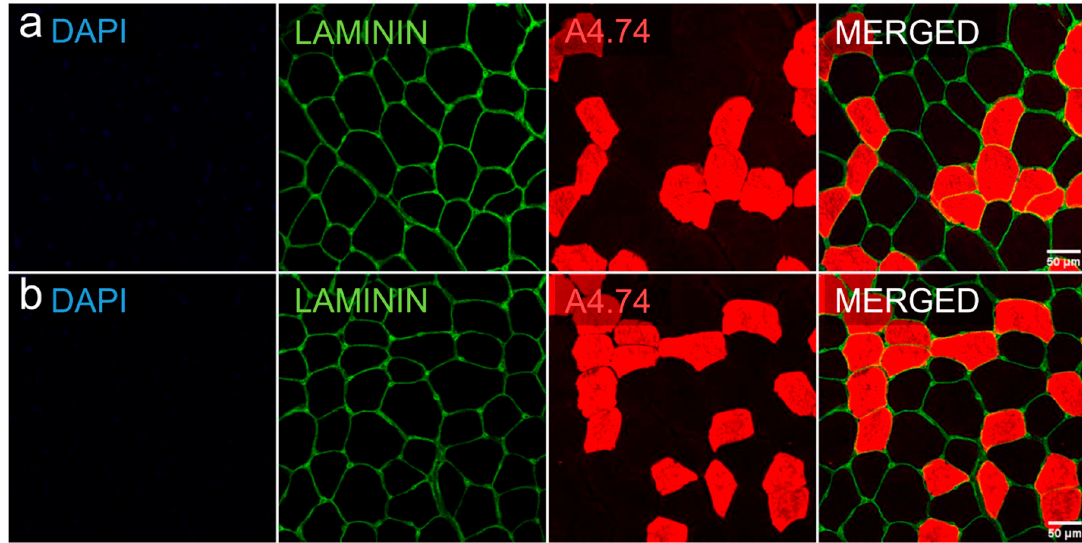
Figure 4. Representative cross-sectional area and fast myosin-based fiber typing of a muscle biopsy with Dapi (blue), laminin (green) and A4.74 (red, type II)-staining. Row ( a ) baseline, row ( b ) final follow-up.